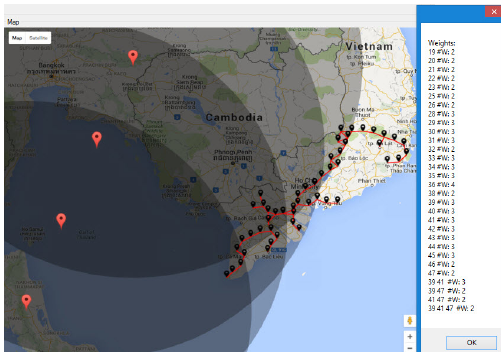
Figure 10. Select a set of nodeswhichplay as gateways of the DSF accordingto the weightsof